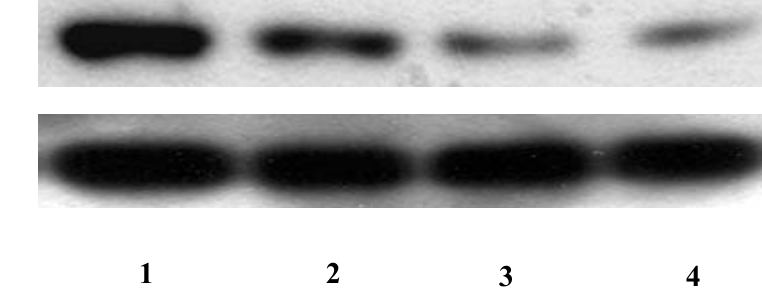
Figure 5. Effect of 1,2-bis(2-methylallyl)disuelfane on the protein expression by Western blot.